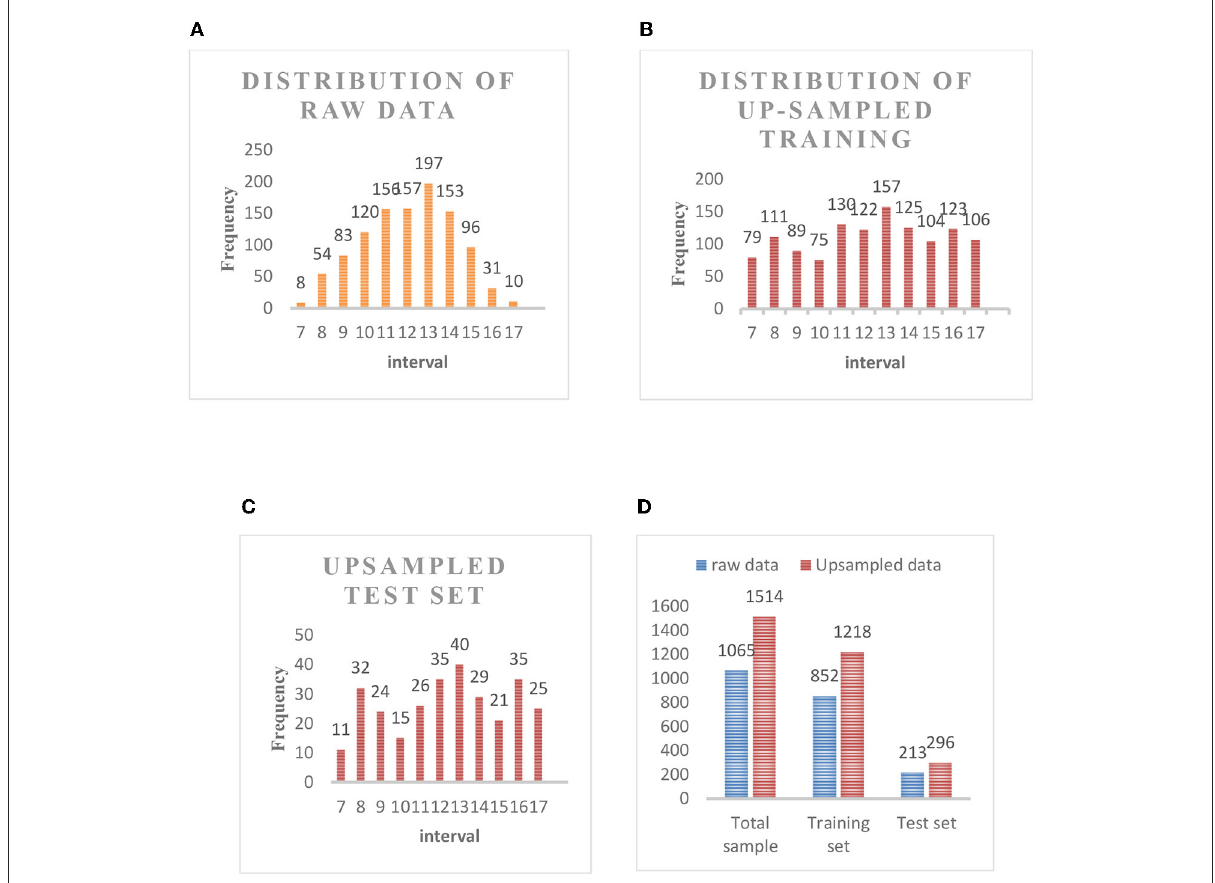
FIGURE5 (A) Distribution of raw data. (B) Distribution of up-sampled training set. (C) Up-sampled test set. (D) Sample data size.